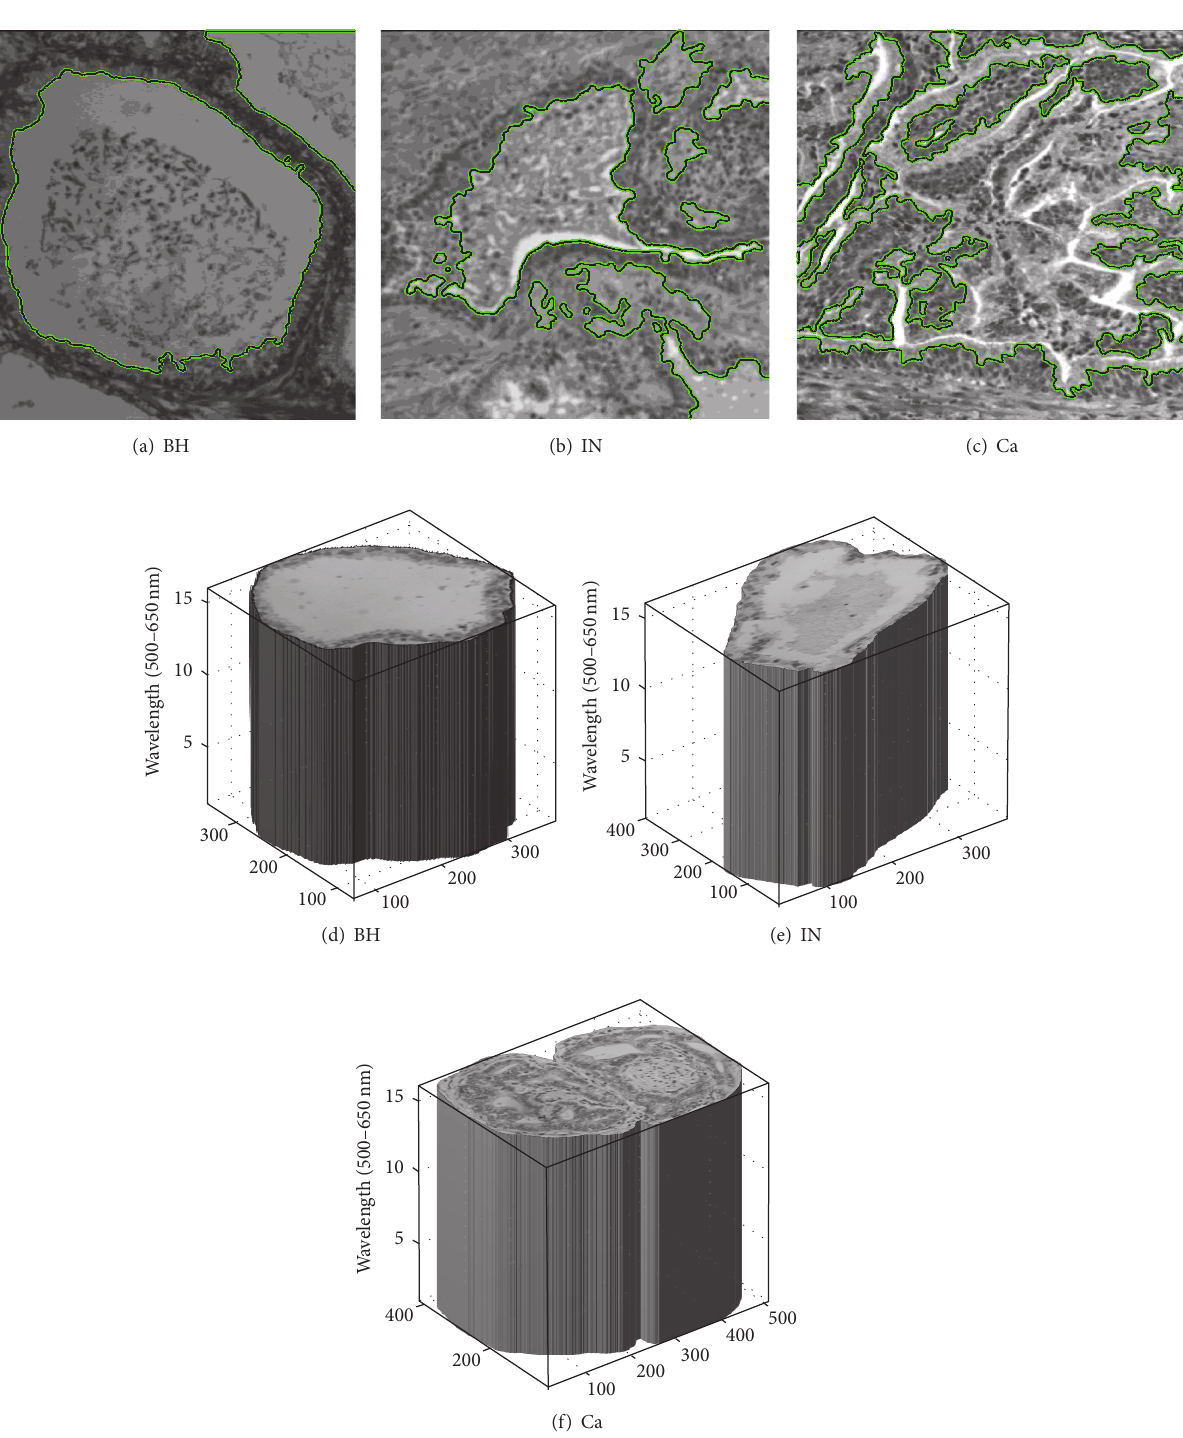
Figure 3: The effect of the snake segmentation technique for 2D multispectral bioimages was applied to the three ABC types (a, b, and c). Schema of 3D multispectral bioimages segmented after area determination from colorectal pathologist (d, e, and